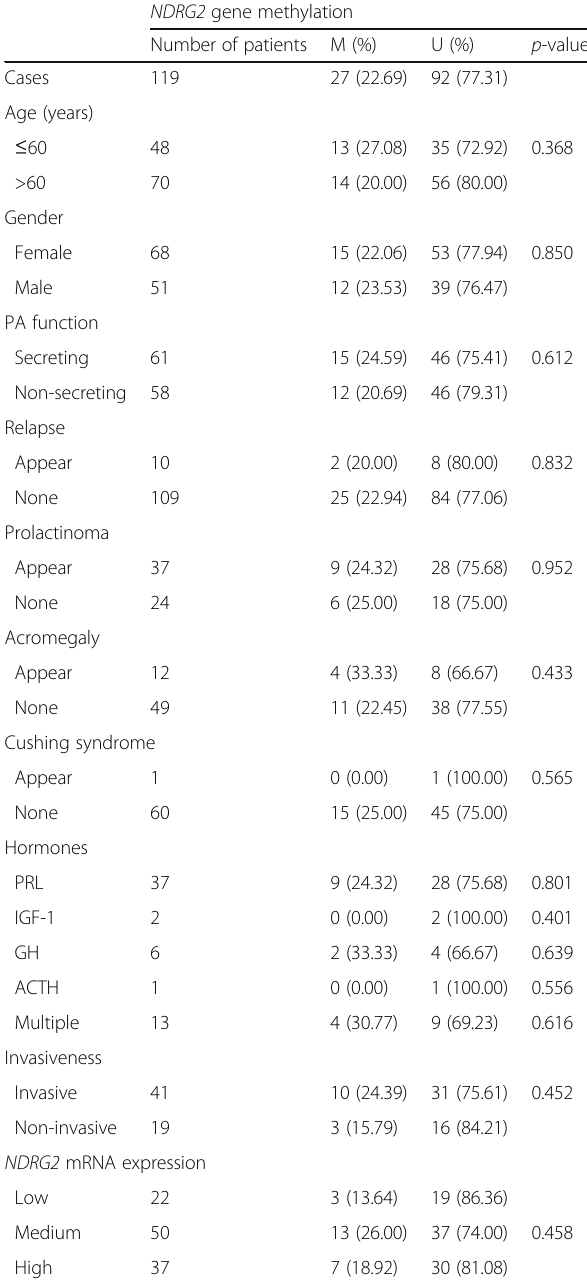
Table 1 Relationship between NDRG2 promoter methylation, patient clinical characteristics, PA invasiveness and NDRG2 mRNA